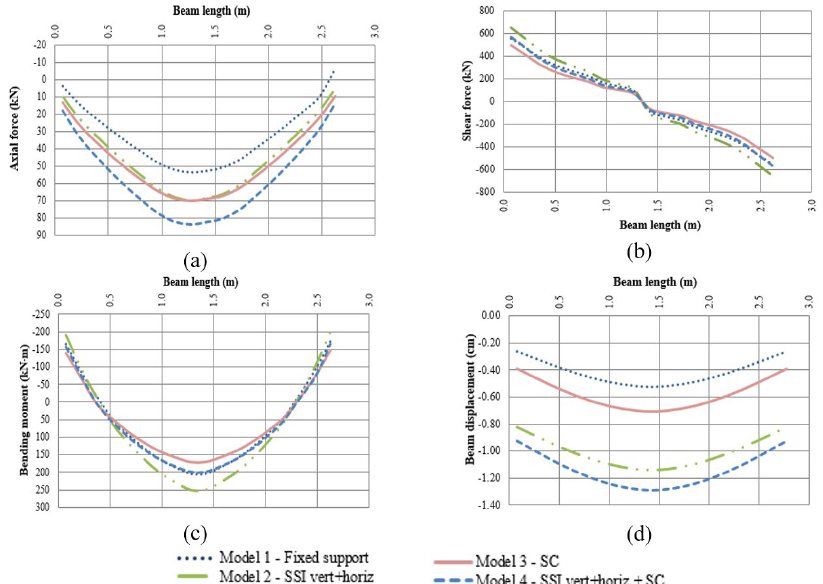
Figure 10. Forces on the support beam of wall 41: (a) Axial force; (b) Shear force; (c) Bending moment; (d)